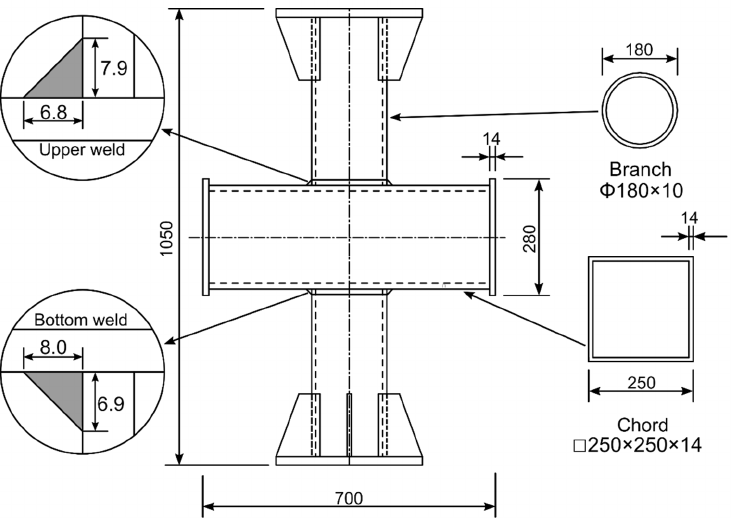
Figure 10. Geometry and configuration of the X90-2 joint specimen (unit: mm) [39,40]. Table 5. Material property at each region of the X90-2 specimen [39,40].